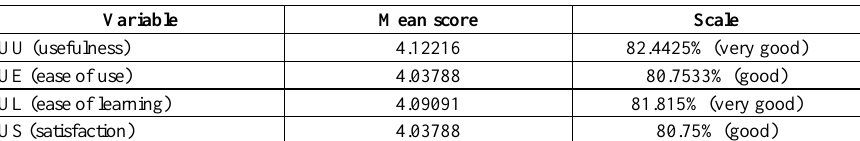
Table 6. Result using